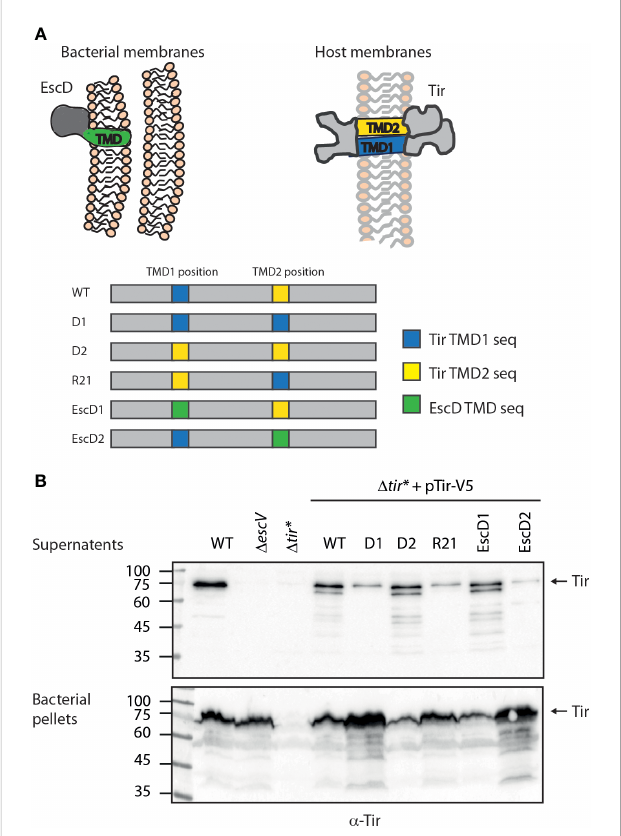
FIGURE 1 Tir TMD2 is critical for protein secretion. (A) Schematic illustration of Tir folding across the host membrane and the organization of TMDs in the WT and TMD-exchanged Tir variants. (B) Protein secretion pro fi les of EPEC strains grown under T3SS-inducing conditions: WT, D escV , D tir *, and D tir * carrying the pTir wt -V5 and Tir TMD-exchanged variants. The secreted fractions were normalized, concentrated from the supernatants of bacterial cultures, and analyzed by western blotting with an anti-Tir antibody. Bacterial pellets were analyzed to verify Tir expression. An arrow at the right of the gels indicates full-length